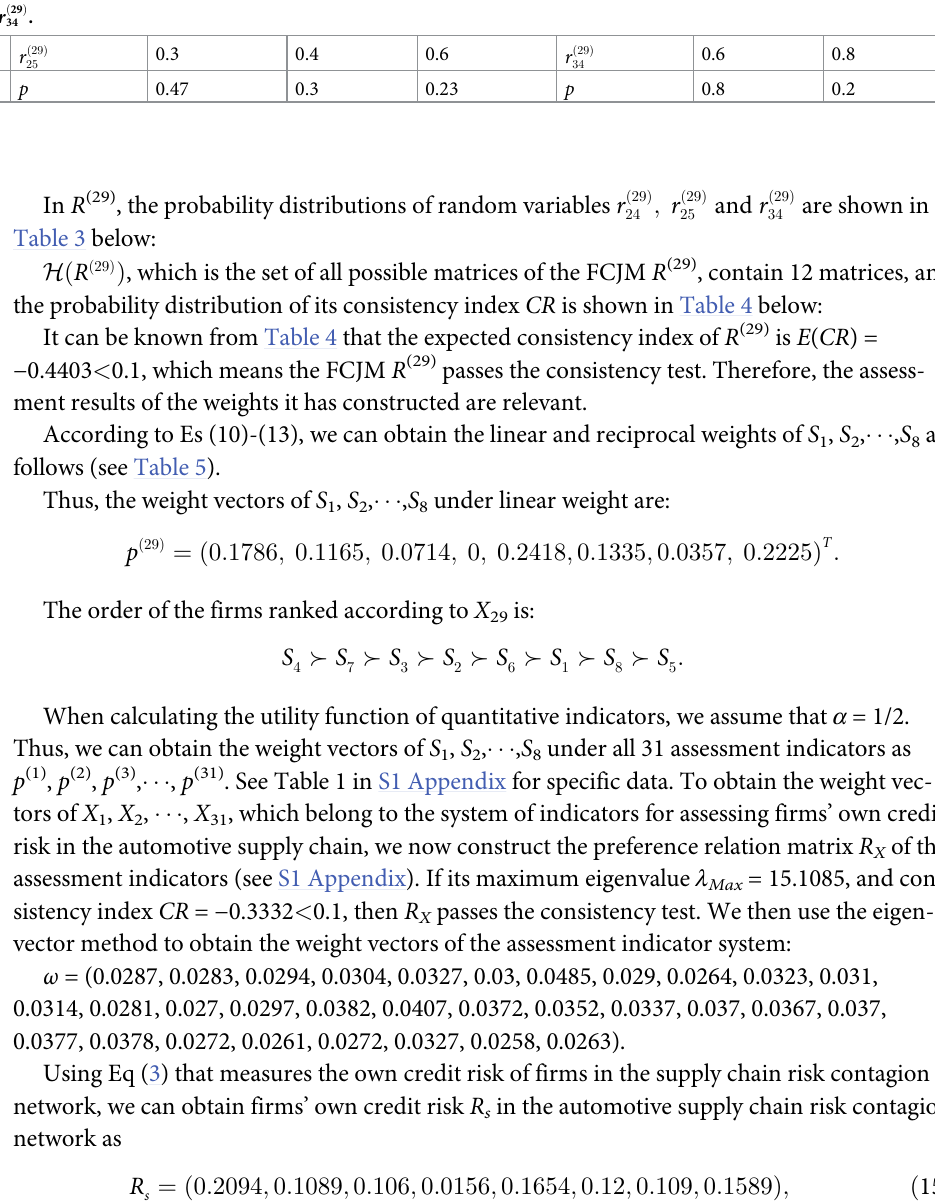
According to Eq (15), the order of the “own credit risk” of the firms in the automotive sup- ply chain is as follows: